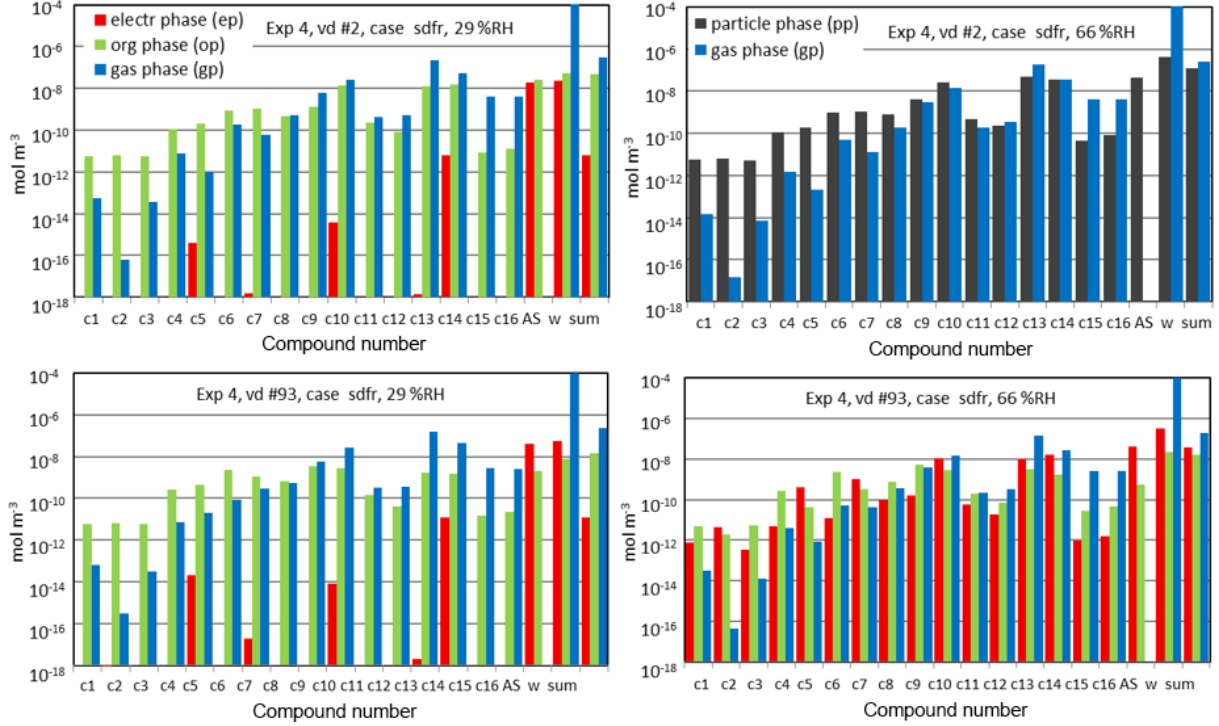
Figure 10. Equilibrium phase partitioning (molm − 3 ) for case sdfr between gas phase, particle phase, electrolyte phase, and organic-rich phase at low (29%) and high (66%) RH for experiment 4, volatility distribution 2 (upper panels), and volatility distribution 93 (lower panels). Compound numbers are c1: diaterpenylic acid acetate, c2: 3-MBTCA, c3: ValT4N9, c4: ValT4N10, c5: 3-hydroxyglutaric acid, c6: ValT4N3, c7: 3-oxoadipic acid, c8: pinic acid, c9: hopinonic acid, c10: glutaric acid, c11: norpinic acid, c12: 2-hydroxyterpenylic acid, c13: 5-COOH-3-OH-pentanal, c14: succinic acid, c15: 10-oxopinonic acid, c16: 4-oxopinonic acid, ammonium sulfate (AS), water (w), and the sum of the compounds